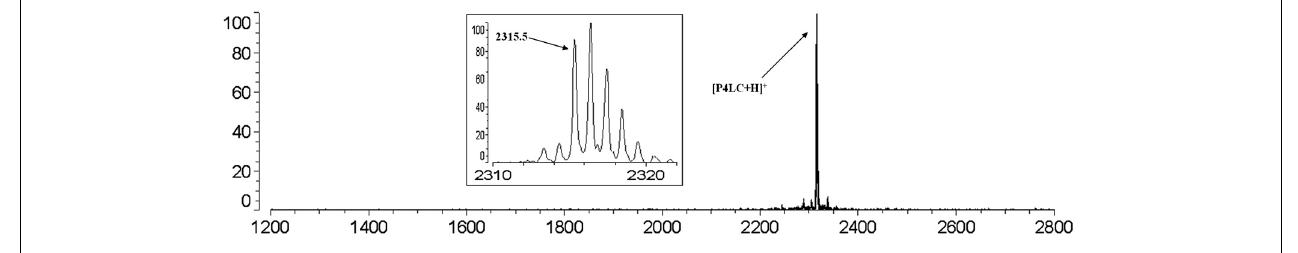
FIGURE 2 | MALDI-TOF mass spectrum of P4LC (m/z: 2315.5) obtained after purification indicates a 3:1 LVFX/Pep-4 loading stochiometry. No peaks assignable to Pep-4 or intermediately